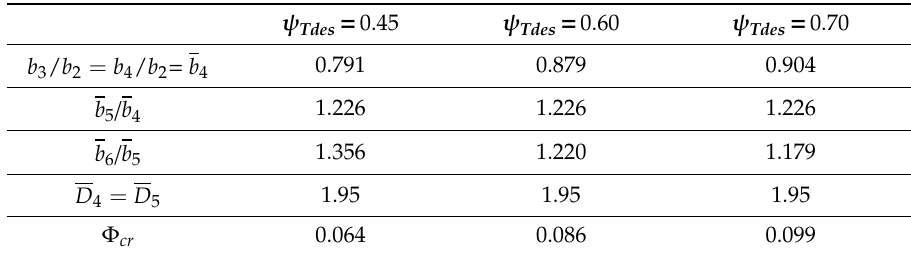
Table 2. Dimensions of the return channels of the stages with 0.70 (preliminary design).